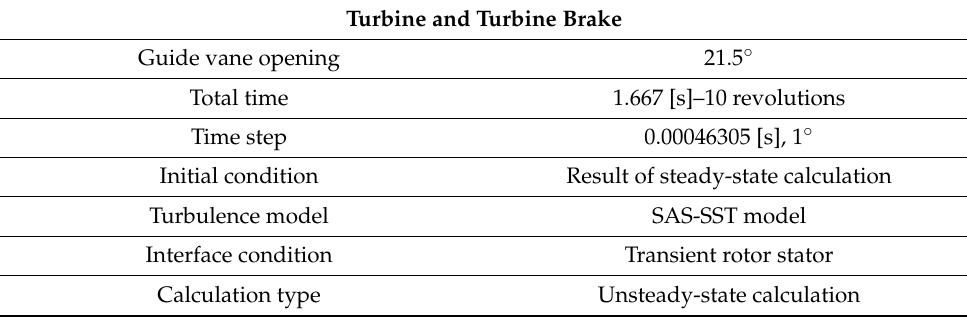
Table 4. Boundary conditions for unsteady-state calculation predicting the transition